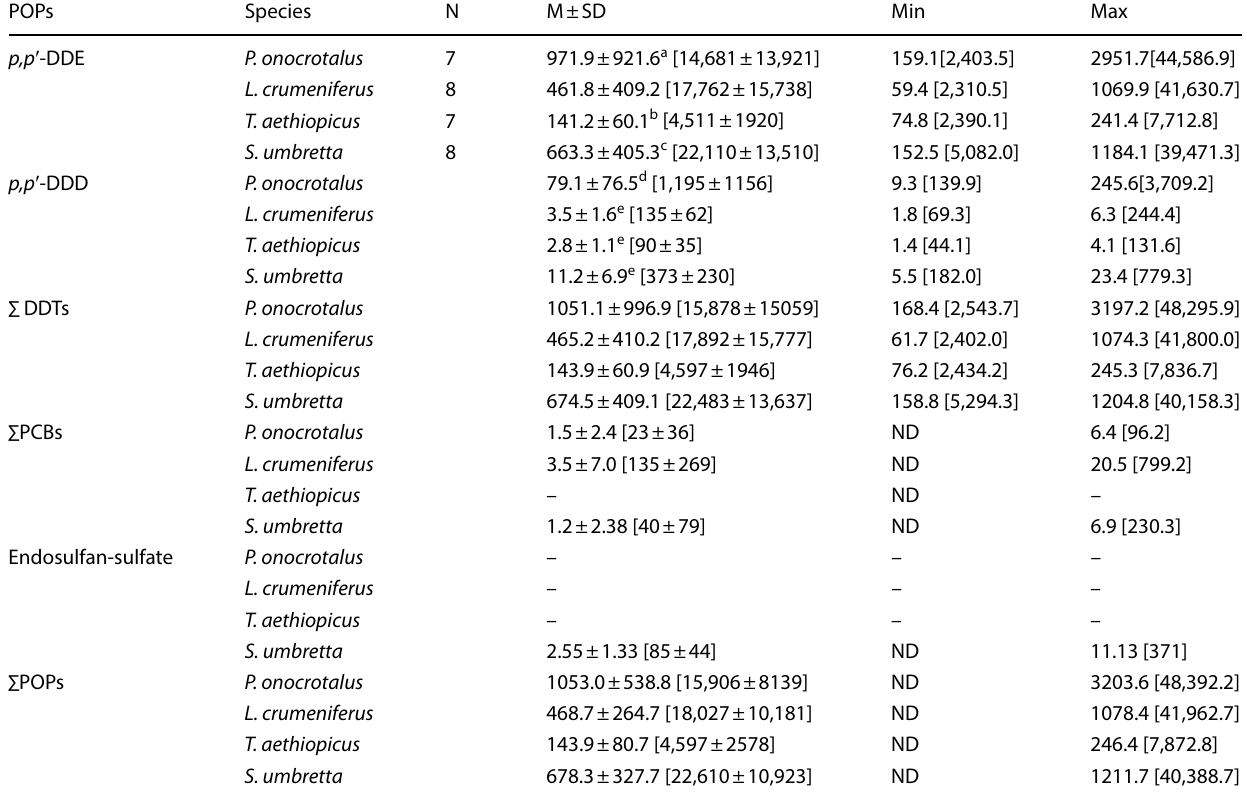
Table 2 Mean (M) value of p,p’ -DDE, p,p’ -DDD, ∑DDTs and ∑PCB (ng g-1 ww [ ng g-1 lw])